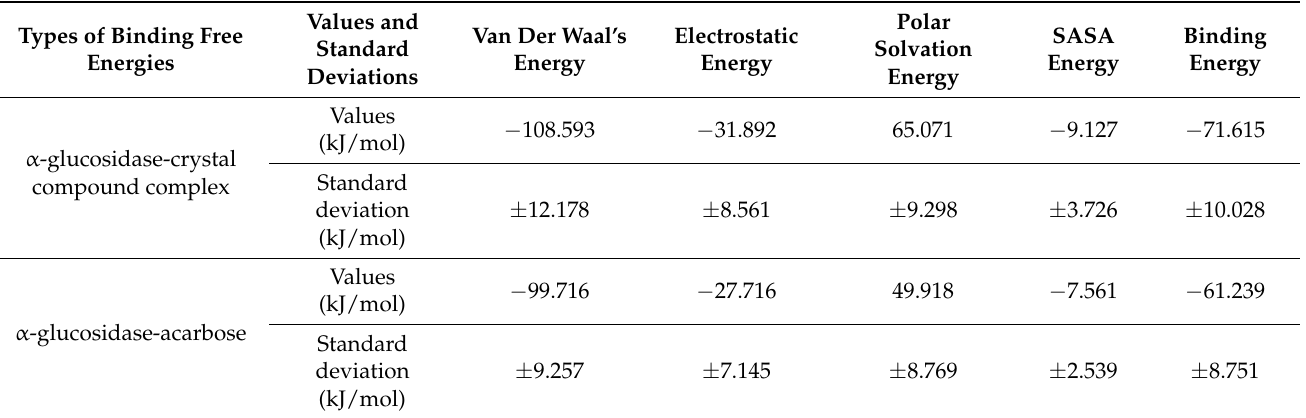
Table 3. Binding free energy calculations for α -glucosidase–crystal compound complex and α - glucosidase–acarbose